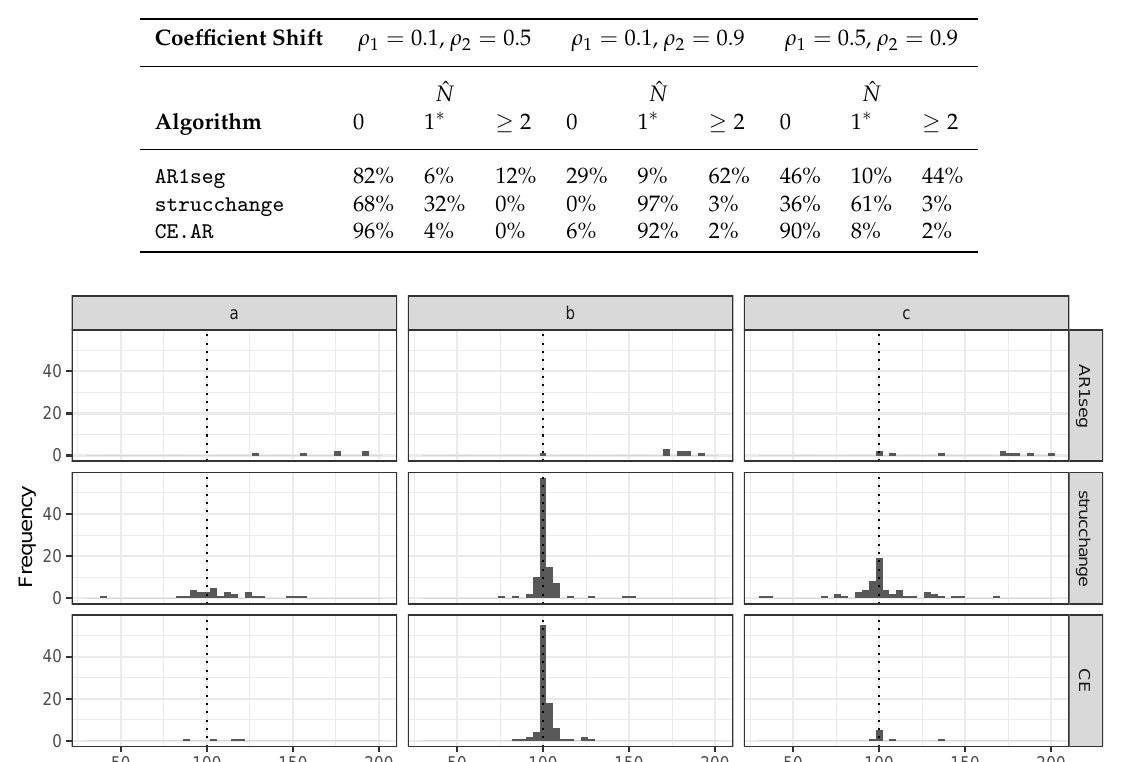
Table 3. The estimated number of change-points under scenario 2.